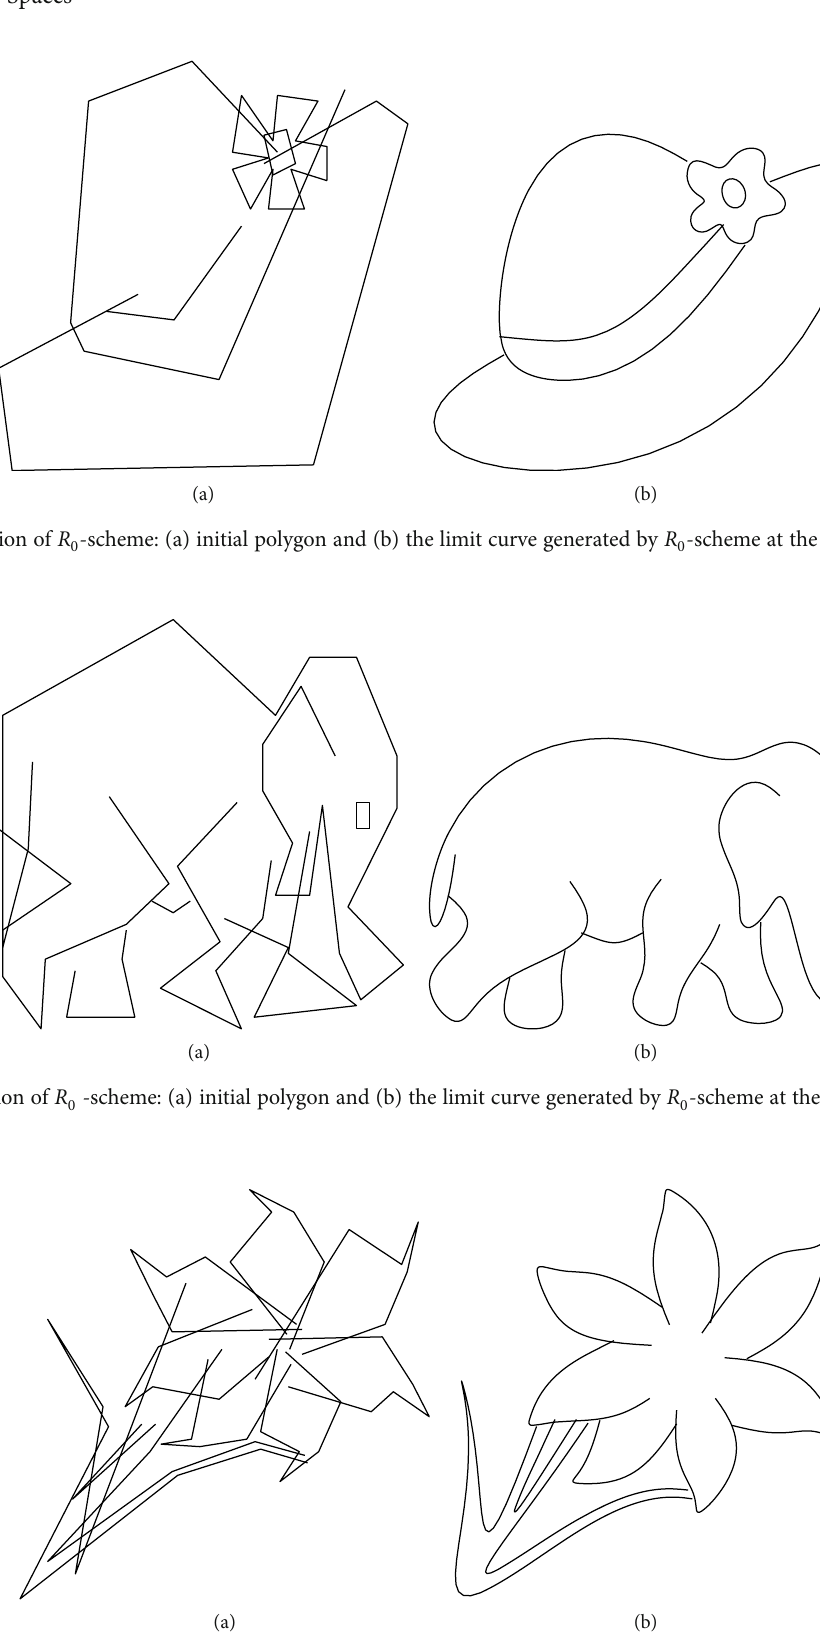
-scheme: (a) initial polygon and (b) the limit curve generated by R 1